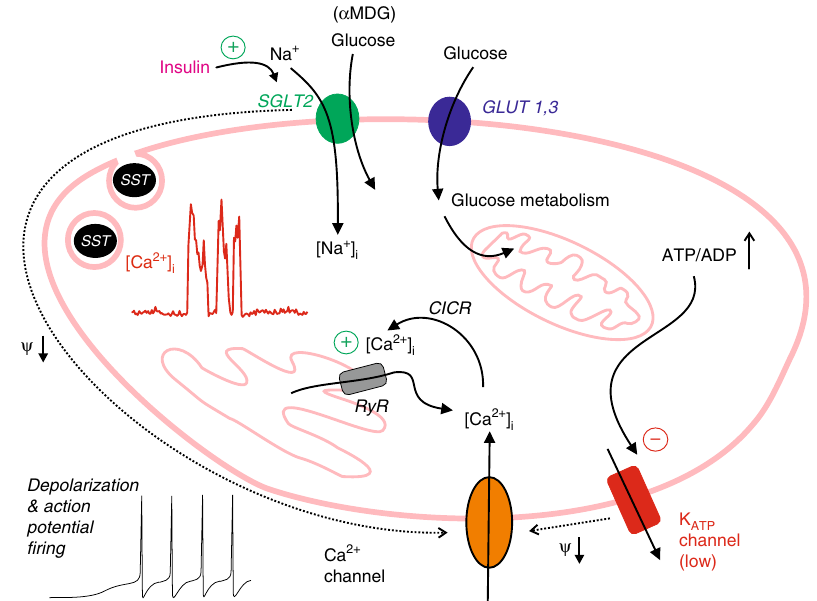
Fig. 8 Schematic summarising the effects of insulin in δ cells. Relationship between SGLT2-mediated glucose uptake and δ -cell electrical activity, Ca 2 + entry, Ca 2 + -induced Ca 2 + release (CICR) and somatostatin release. Insulin stimulates SGLT2 activity. The operation of SGLT2 is electrogenic Na + - dependent glucose uptake mediated by SGLT2 gives rise to a small depolarising current and may (in some cells with suf fi ciently high SGLT2 expression and/or low K ATP channel activity) trigger electrical activity (action potential fi ring). The associated increase in cytoplasmic Ca 2 + ([Ca 2 + ] i ) leads to intracellular Ca 2 + mobilisation by activation of ryanodine receptors (RyRs) and Ca 2 + -induced Ca 2 + release (CICR). In addition to SGLT2, the δ cells also express the glucose transporters GLUT1 and GLUT3. Glucose uptake via these transporters accounts for 99% of glucose uptake. Metabolism of glucose leads to K ATP channel closure, membrane depolarisation, electrical activity and